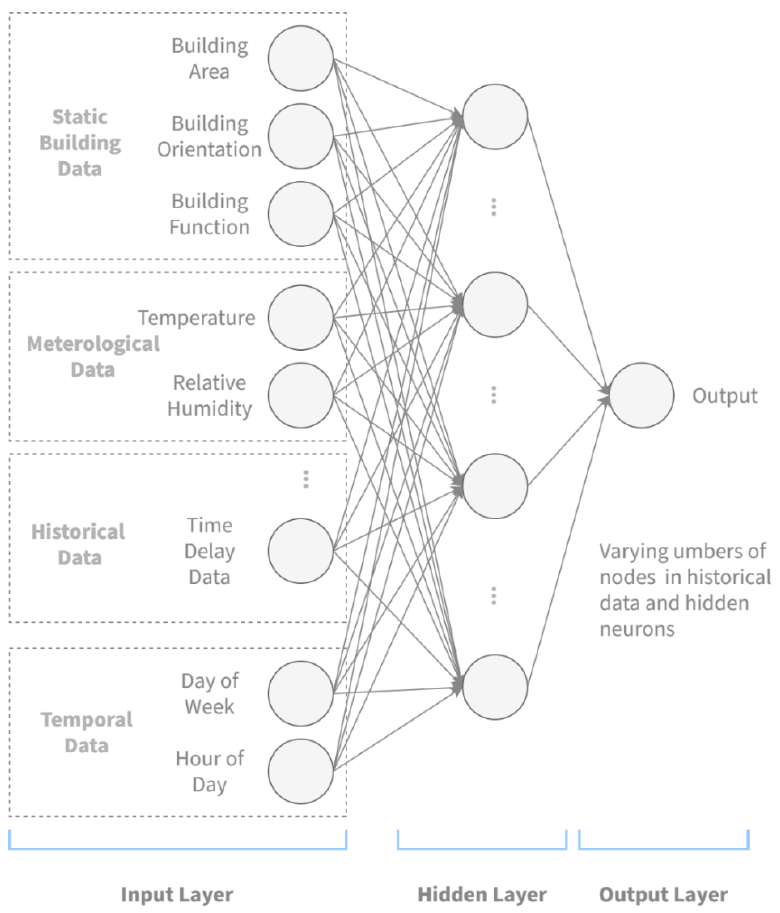
Figure 7. Structure of the artificial neural network.